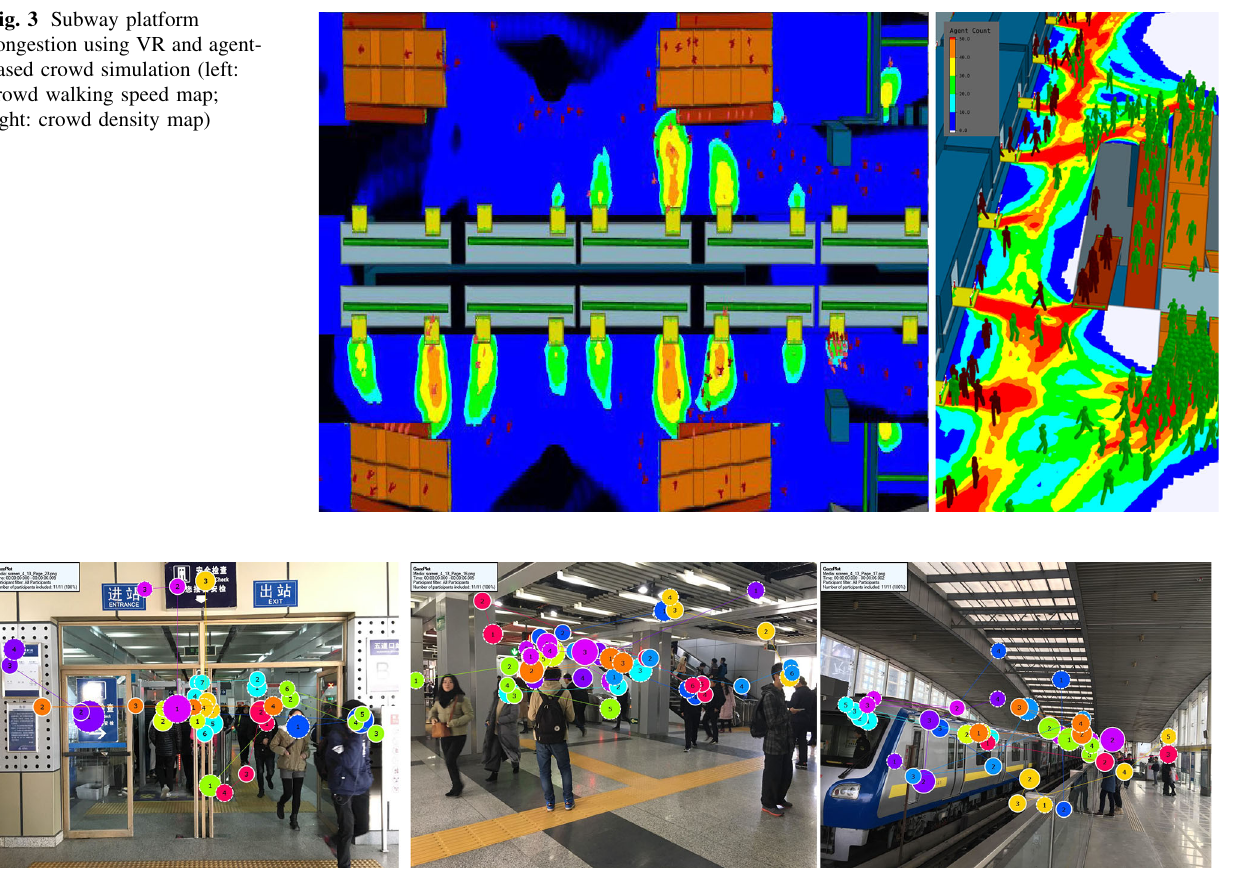
Fig. 4 Gaze plot map based on integrated ET with VR of the existing rail